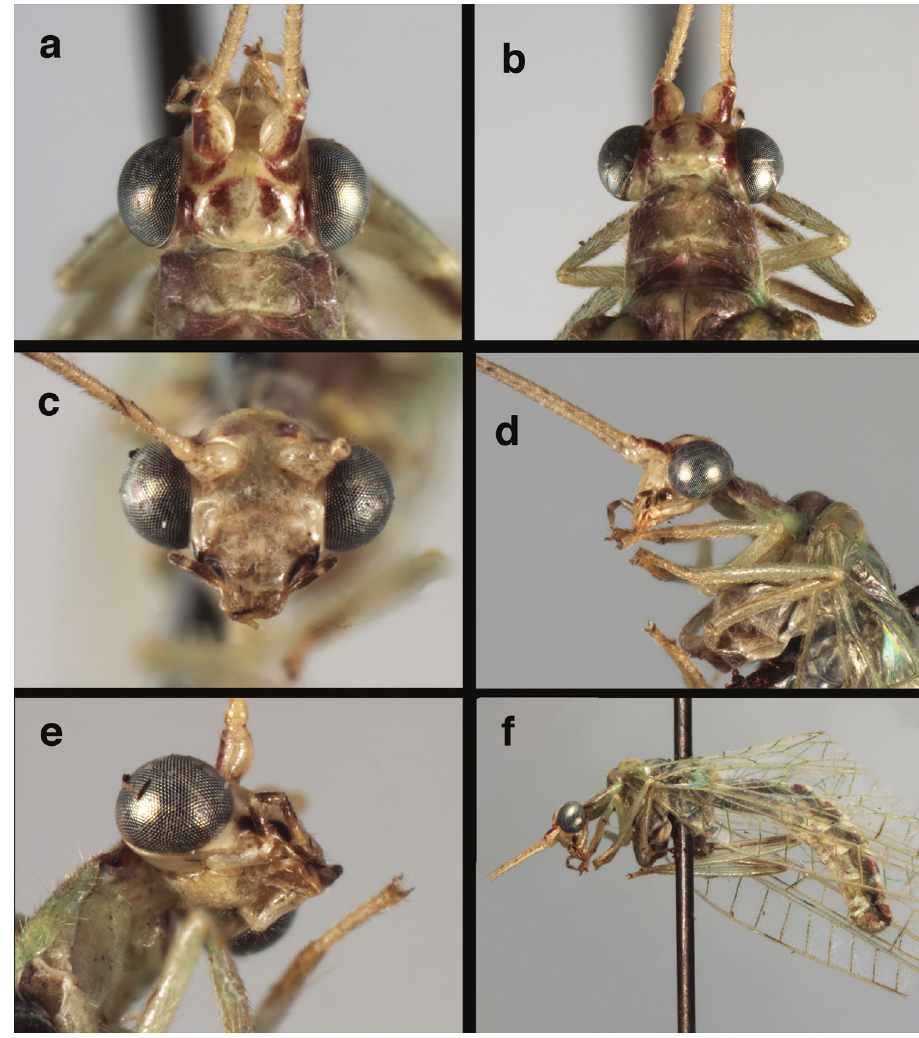
Figure 57. Ungla martinsi Sosa: External features, ( a ) head, dorsal ( b ) head, prothorax, dorsal ( c ) head, frontal ( d ) head, lateral ( e ) head, ventrolateral ( f ) body, lateral (all: Venezuela, Aragua, DEBU; a, b, d, f female; c, e